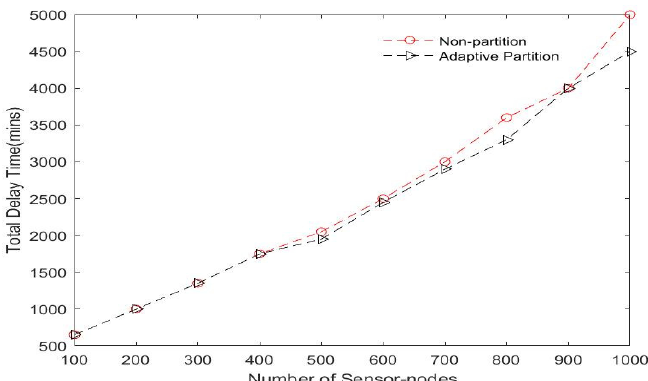
Figure 8. Comparing adaptive and non-adaptive partition schemes in terms of the number of sensor nodes.